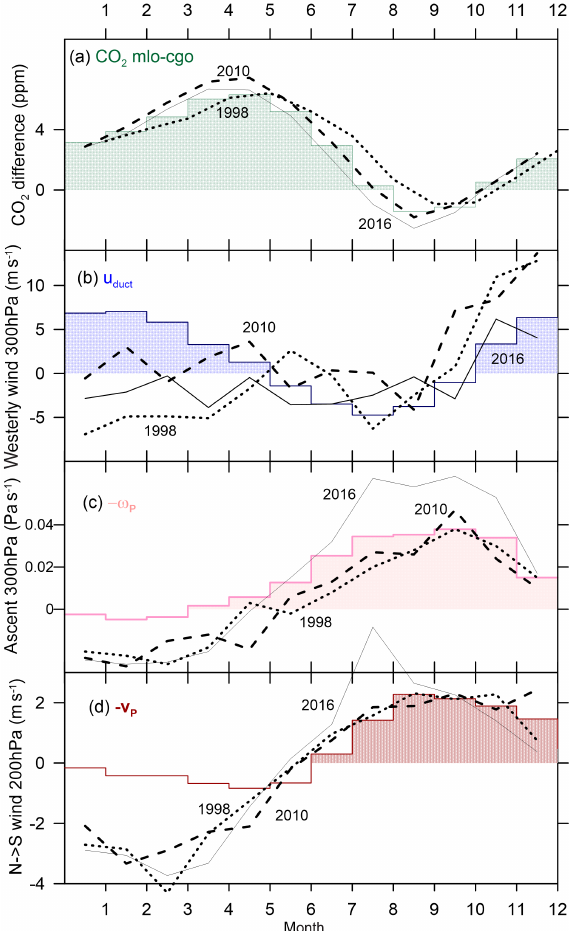
Figure 7. The monthly averages of dynamical factors governing CO 2 IH exchange over the last 25 years. (a) Detrended CO 2 par- tial pressure differences mlo–cgo (green), (b) Pacific eddy transport index u duct (dark blue), (c) Pacific Hadley transport indicated by uplift at 10–15 ◦ N (- ω P , light red), and (d) north-to-south transport (- v P , dark red). On average, coincidence of shading in wind indices and shaded months of IH (cid:49) CO 2 is a precondition for increased IH mixing (reduced IH gradient). The more anomalous transport years, 1998 (dots), 2010 (dashes), and 2016 (black line) are shown for each wind index, and for mlo–cgo IH (cid:49) CO 2 .